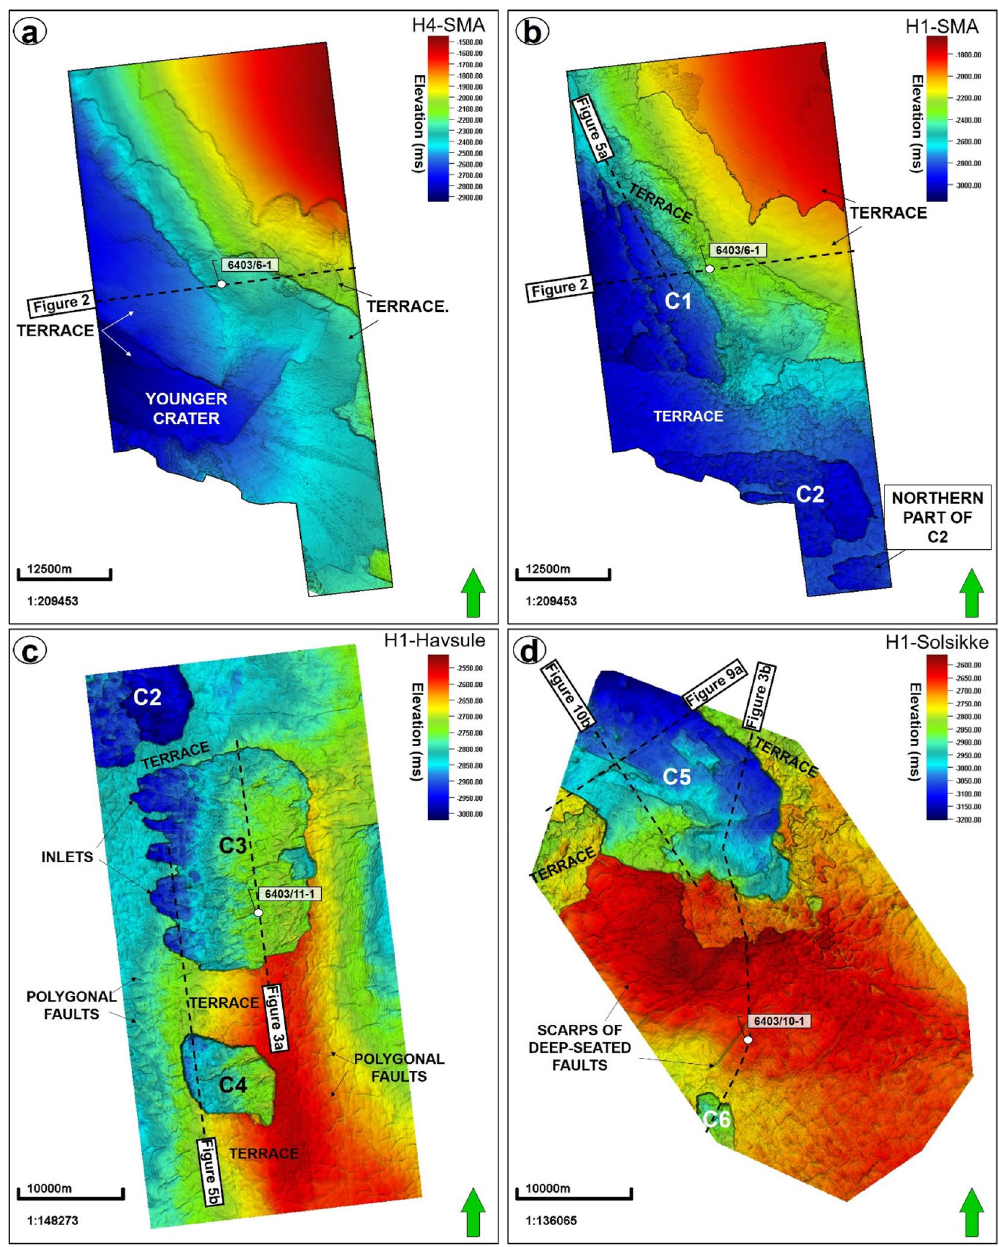
Figure 4. Structural maps of ( a ) the seafloor (horizon H4) in the SMA area, and horizon H1, i.e., the Top Brygge Formation in the ( b ) SMA ( c ) Havsule and ( d ) Solsikke areas. Also shown on the maps are Craters C1-C6 and the location of some of the interpreted seismic